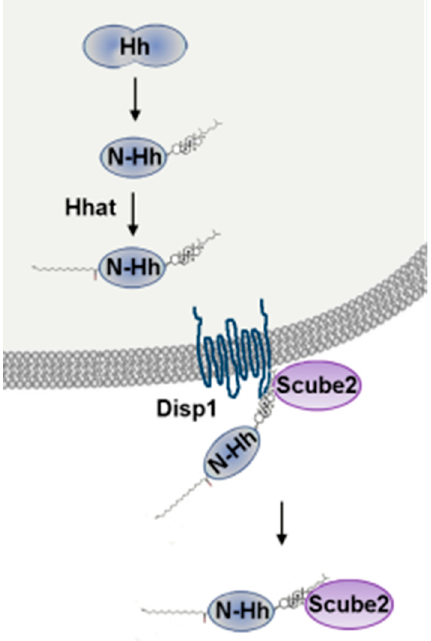
Figure 1. Shh post-transcriptional modification and secretion. Shh is synthetized as